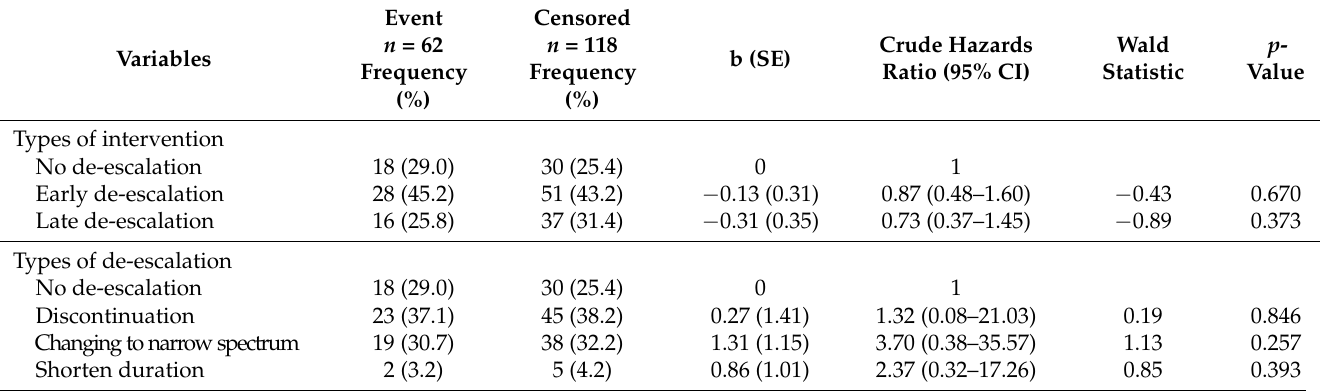
Table 7. Antimicrobial stewardship team related intervention on all-cause 30-days mortality in patients suspected with bacterial infection on extended or restricted antibiotic using simple Cox proportional hazards regression ( n =